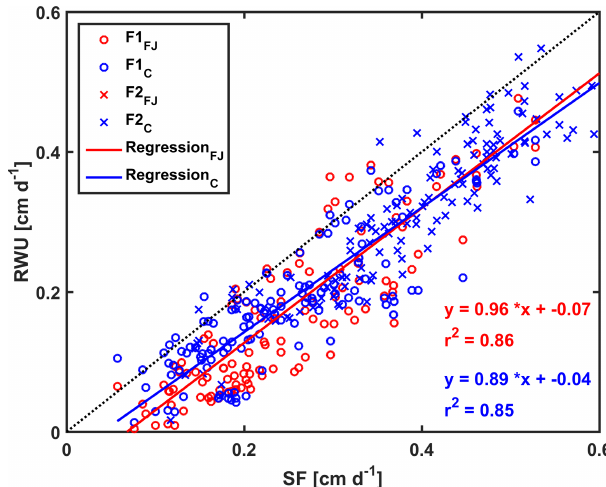
Figure 11. Correlation between sap flow (SF) and root water uptake (RWU) simulated by the Feddes–Jarvis (FJ) and Couvreur (C) mod- els of the stony (F1) and silty (F2) soils. The crosses (x) obtained by the FJ and C models overlapped in F2.